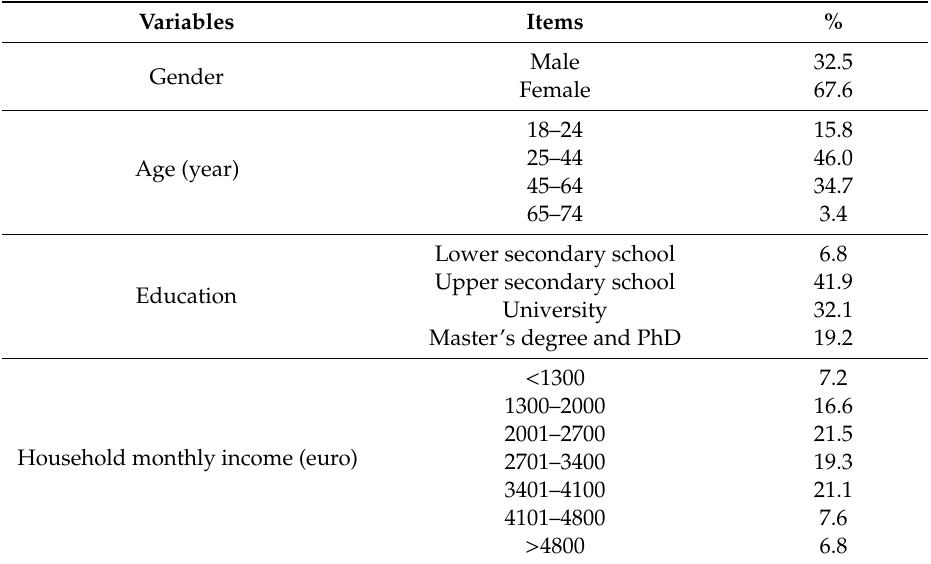
Table 2. Socio-demographic characteristics of